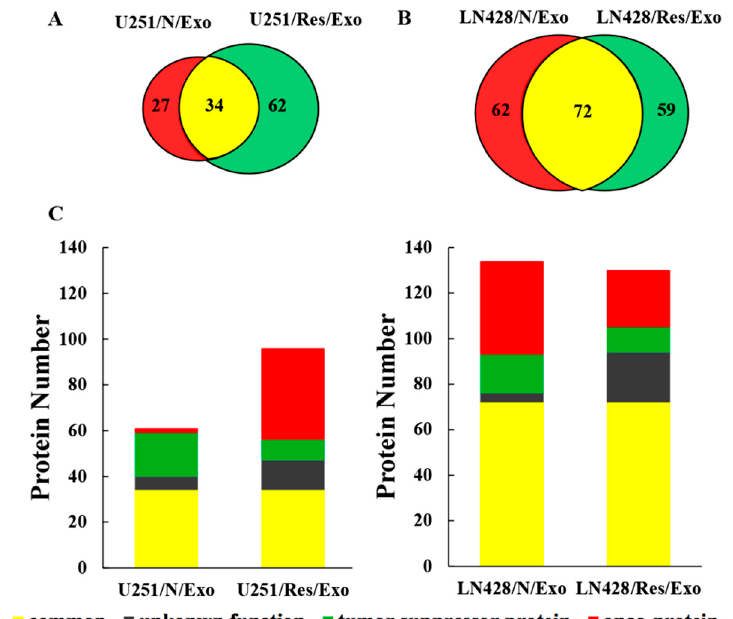
Figure 4. Proteomic analysis of U251 and LN428 cell-derived exosomes. ( A , B ) Venn diagram of liquid chromatography-mass spectrometry (LC-MS/MS)-identified proteins from U251 and LN428 cell-derived exosomes. ( C ) Subgroup numbers: Red, onco-proteins; Green, tumor suppressor proteins; Grey, proteins with unknown function; Yellow, common proteins.